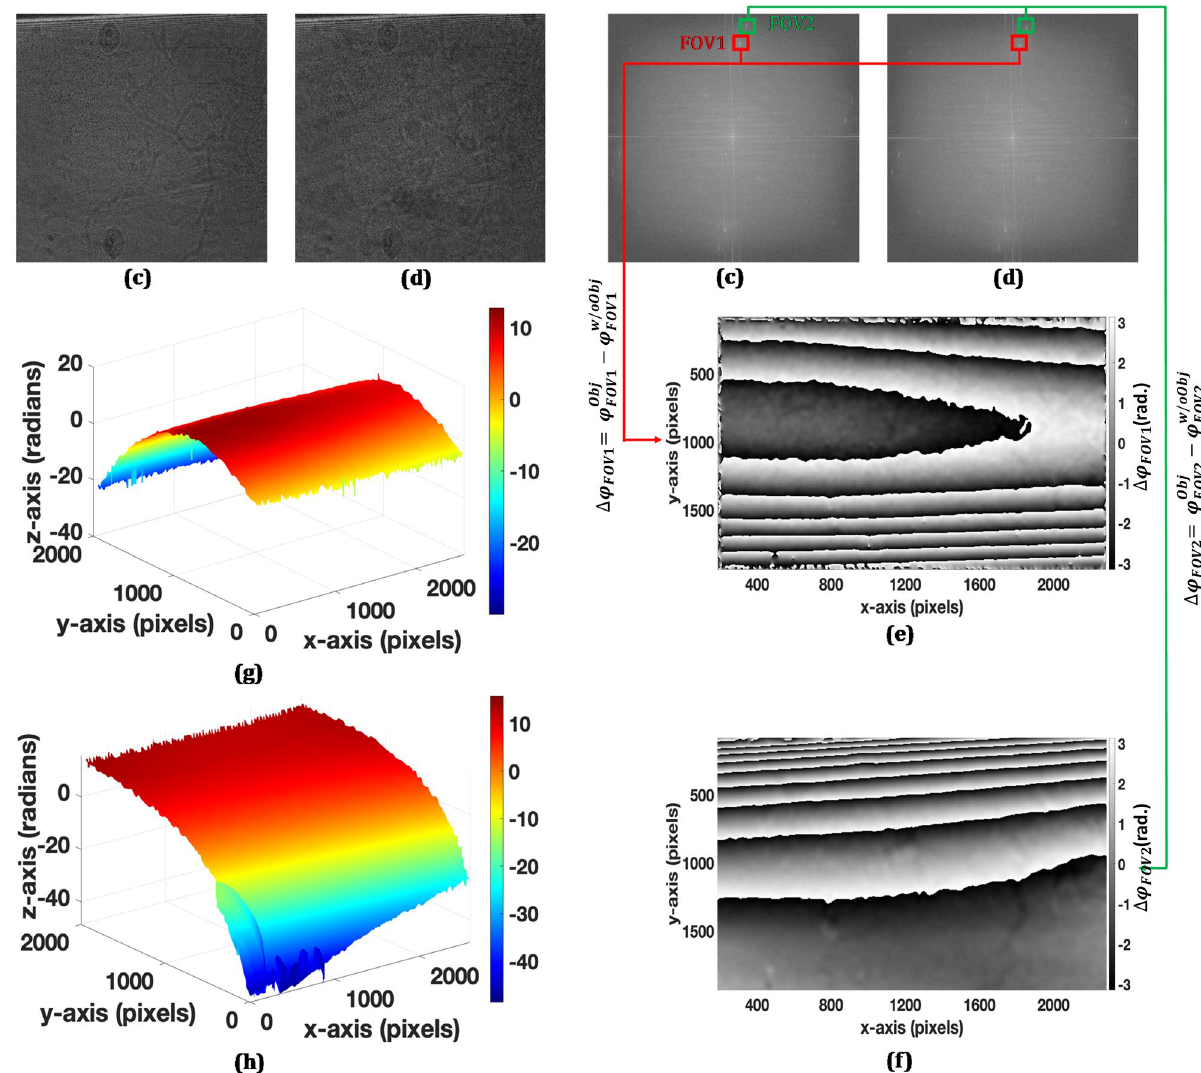
Figure 6. ( a ) Recorded digital hologram with the glass plate, ( b ) recorded digital hologram without the glass plate, ( c – d ) Fourier transform spectrums of ( a ) and ( b ), ( e – f ) wrapped phase difference maps corresponding to FOV1 and FOV2, respectively, and ( g – h ) unwrapped phase distributions corresponding to ( e – f ),